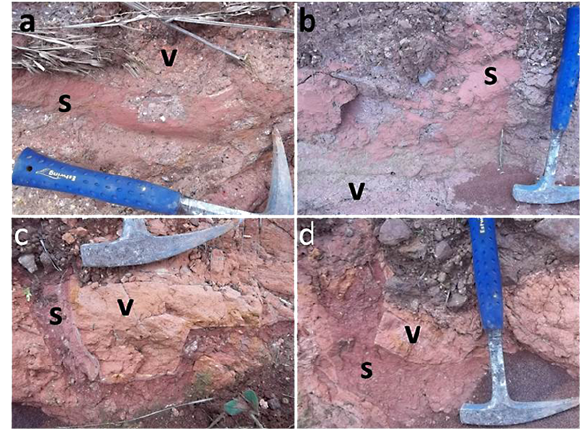
Fig. 5. Silicic ATC- and ATP-type rocks (V) in contact with red clayey siltstone (S): (a, b) peperites in the base of an ATC-type rock; ( c and d ) fractures in the top of an ATP-type rock filled with sediment, in the central region of the Paraná